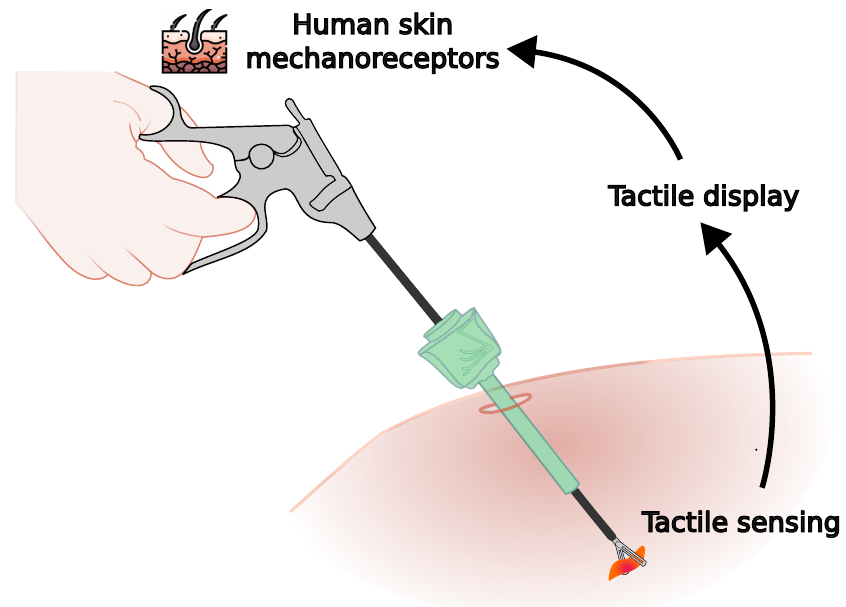
Figure 1. Tactile feedback in minimally invasive surgery. Tactile sensors convert the tactile stimuli into data sent to the tactile display, which recreate the same feedback sensation into the human skin